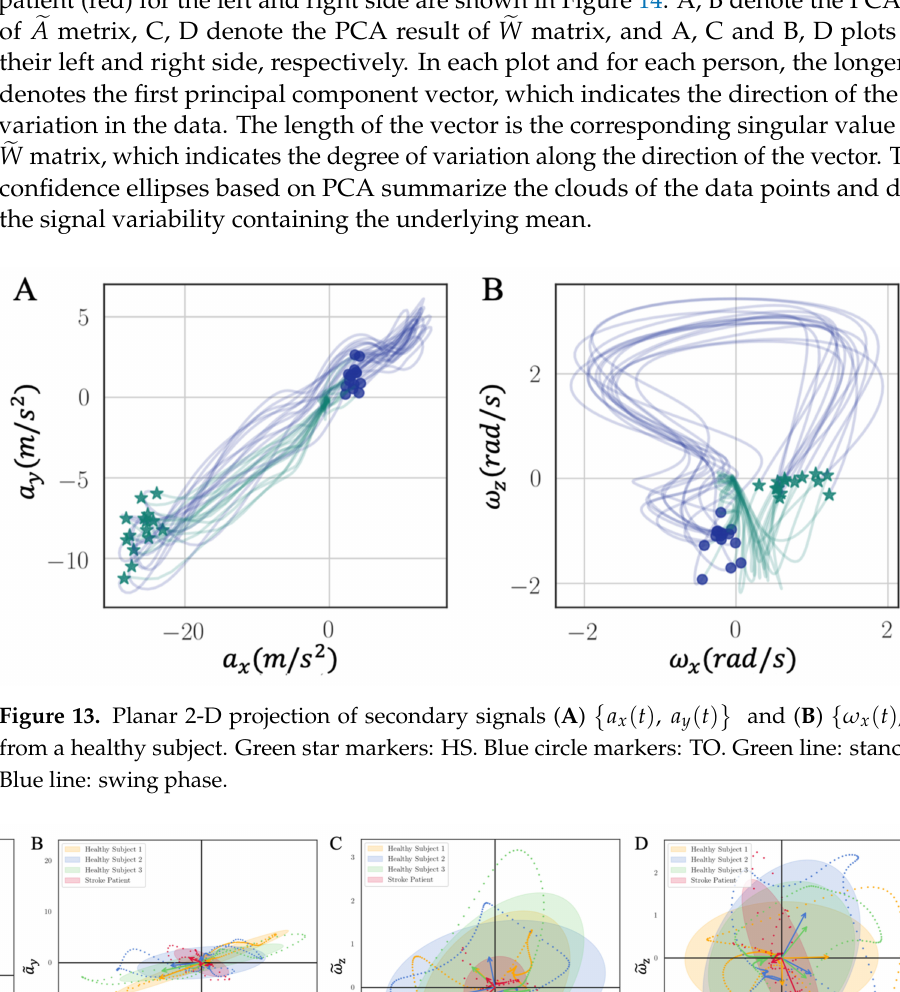
Figure 14. PCA results of (cid:101) A , (cid:101) W matrices for three healthy subjects and one stroke patient. The dotted lines represent the normalized median cycle of each person. The ellipses show 95% confidence region. The arrows are plotted by the eigenvectors, and its length equal corresponding eigenvalues. ( A , C ) For left foot and ( B , D ) for right